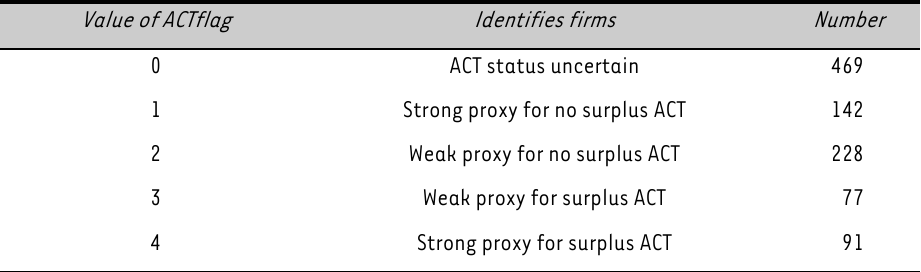
TABLE 3: Summary of variable ACT flag Value of